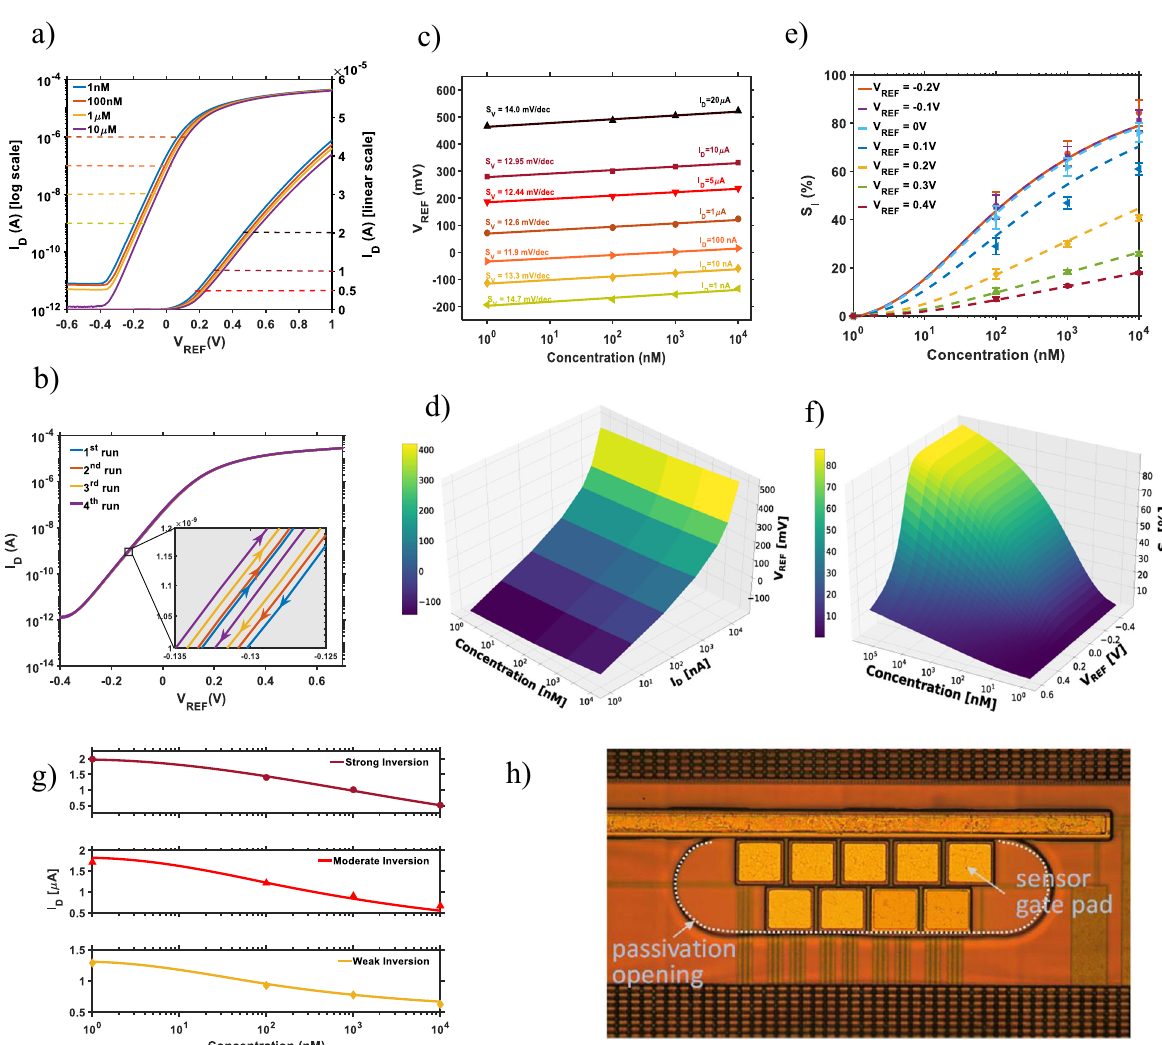
Fig. 4 Experimental electrical validation of the proposed cortisol sensor and extracted sensitivities. a I D – V G transfer characteristics of cortisol sensor, in semi-logarithmic and linear scale for different cortisol concentrations. b Drift study and hysteresis. c Voltage sensitivity, S V , for different current levels in subthreshold and in linear working regime. d Experimental 3D mapping of extracted voltage sensitivity as a function of concentration and drain current (all range of experiments). e Comparison between the current sensitivity in the two working regimes, the solid symbols indicate the real data and the dashed lines indicate the expected current sensitivity based on calibrated modeling. f 3D mapping current sensitivity, S I , for different applied voltages (all operation range) and analyte concentration based on calibrated compact modeling using uni fi ed model of Eq. (2). g Predictive drain current model (solid line), based on Eq. (2), vs. cortisol concentration compared to data points (symbols) in weak ( V REF = − 0.2 V), moderate ( V REF = 0.1 V) and strong inversion ( V REF = 0.4 V). h Photo of the 0.18 μ m CMOS silicon chip designed and used in this work; the central pads are the top gate contacts of FET